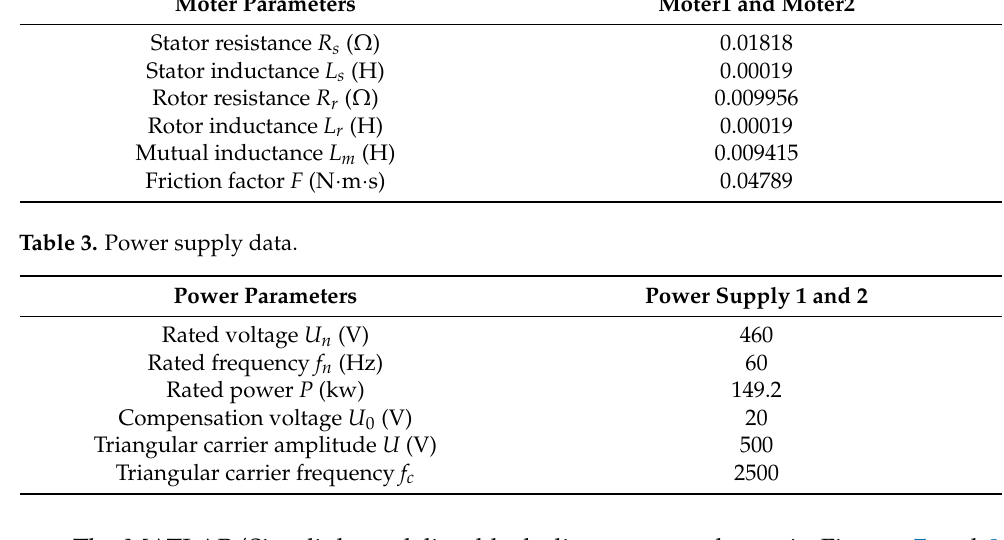
The MATLAB/Simulink modeling block diagrams are shown in Figures 7 and 8. Figure 7 is the Simulink block diagram of inverter power supply, and Figure 8 is the Simulink block diagram of electromechanical system. The two parts are connected through three-phase AC power supply. The sfun_test function is the modeling of fixed-shaft gear shafting.